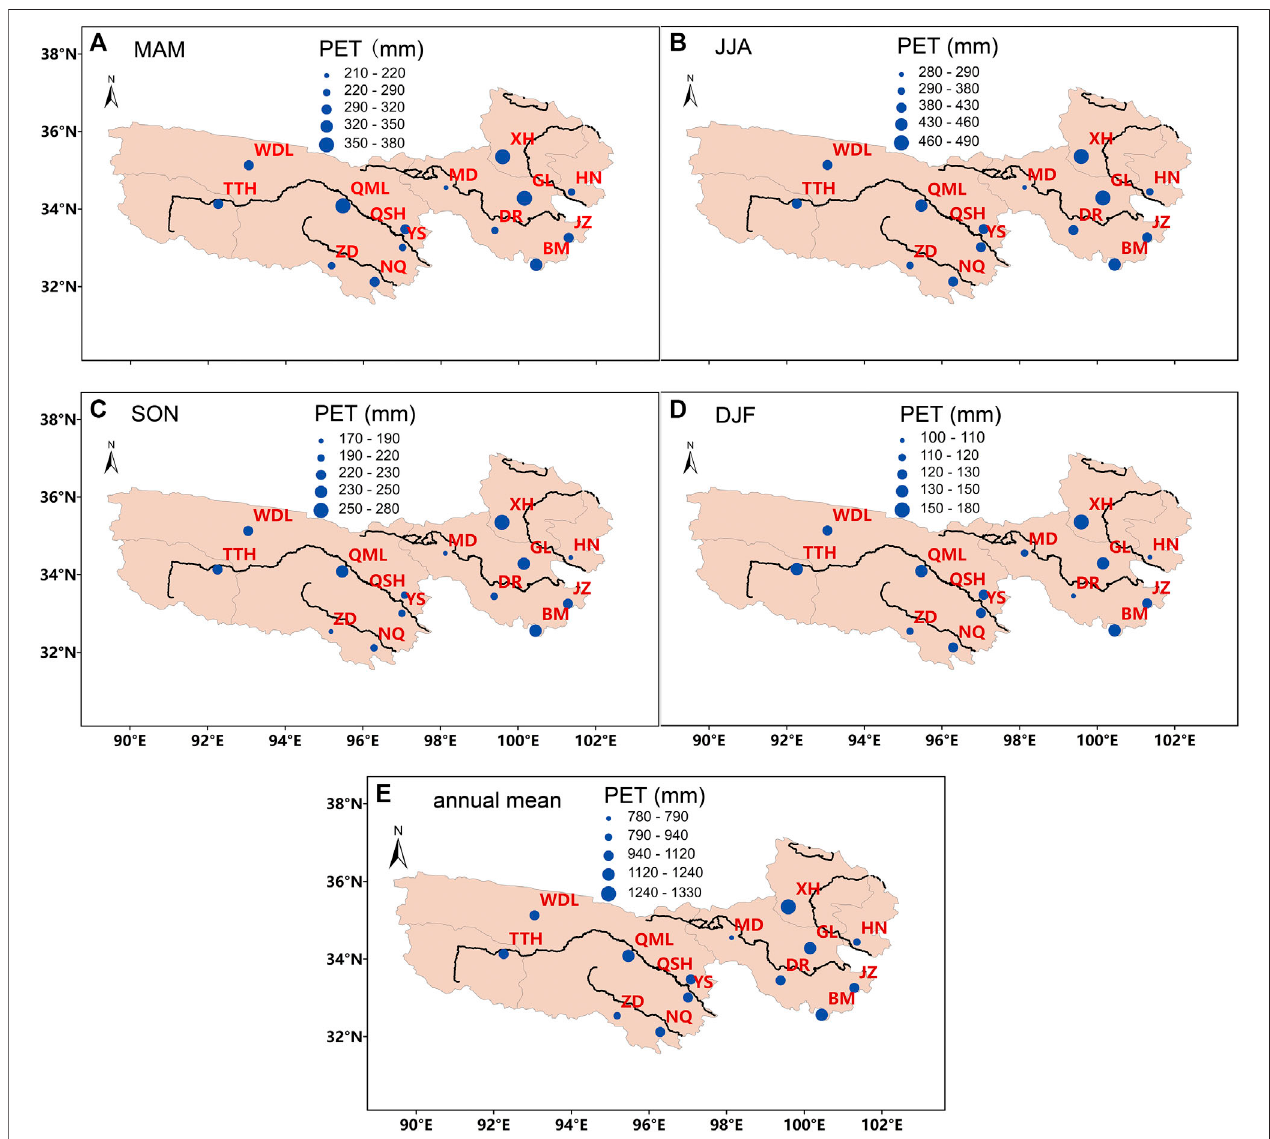
FIGURE 3 | PET variation trend in four seasons and annual mean of 14 weather stations in the TRH region. (A) MAM, (B) JJA, (C) SON, (D) DJF, and (E) annual mean.